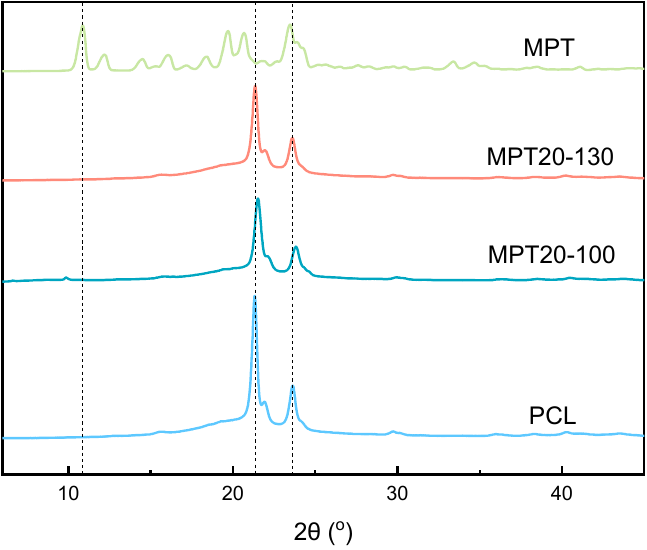
Figure A3. WAXD patterns for PCL/MPT-80/20 at different processing temperatures.